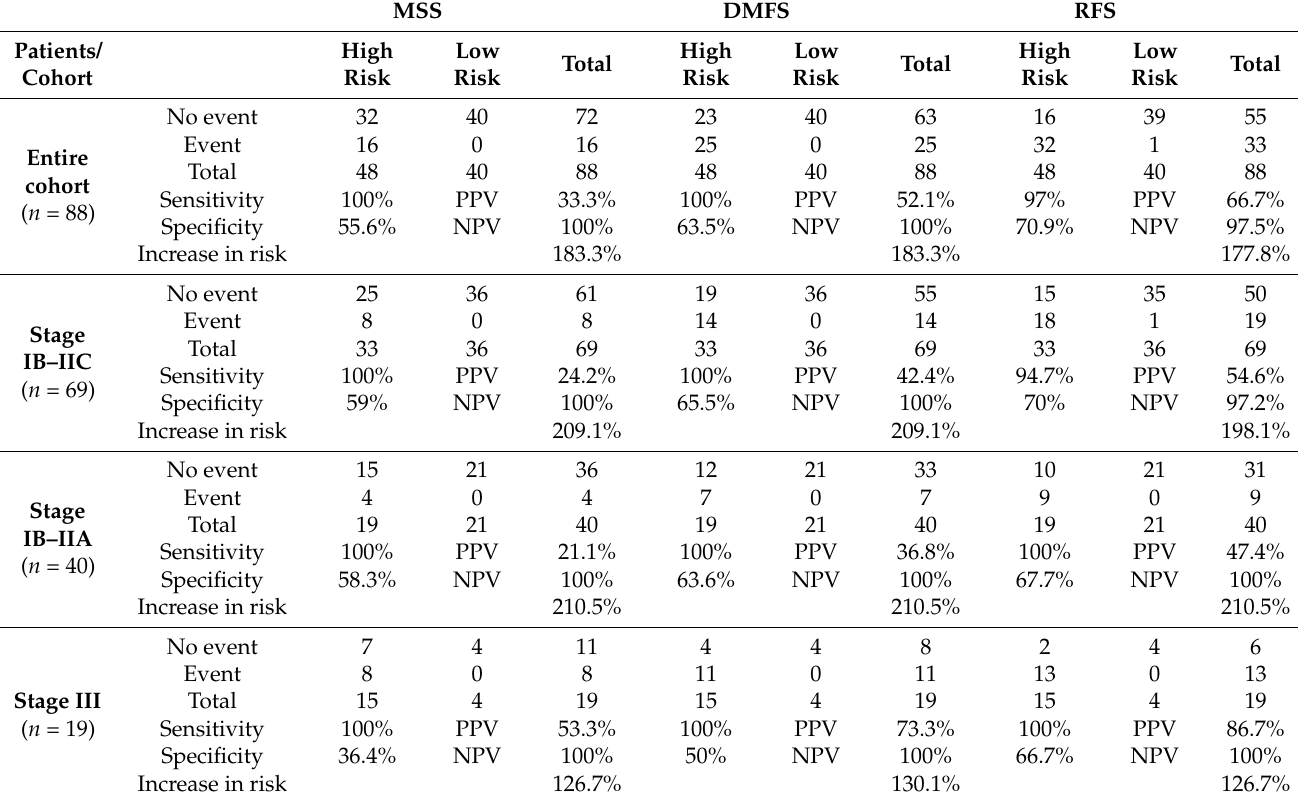
and NPV. Table 3. The event table shows numbers of patients at risk and the distribution of events in the low-risk and high-risk groups with the resulting predictive power of stratification by the seven-marker signature, indicated by sensitivity, specificity, PPV and NPV.